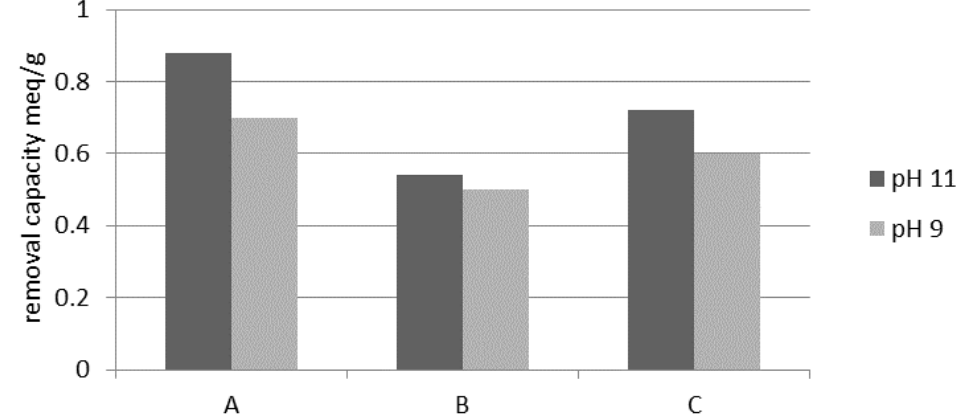
Figure 9. Weathered halloysite ion exchange capacity depending on pH excess and a concentration of the regenerating solution NaCl: A, 5% excess 5; B, 3% excess 3; C, 3% excess 5.